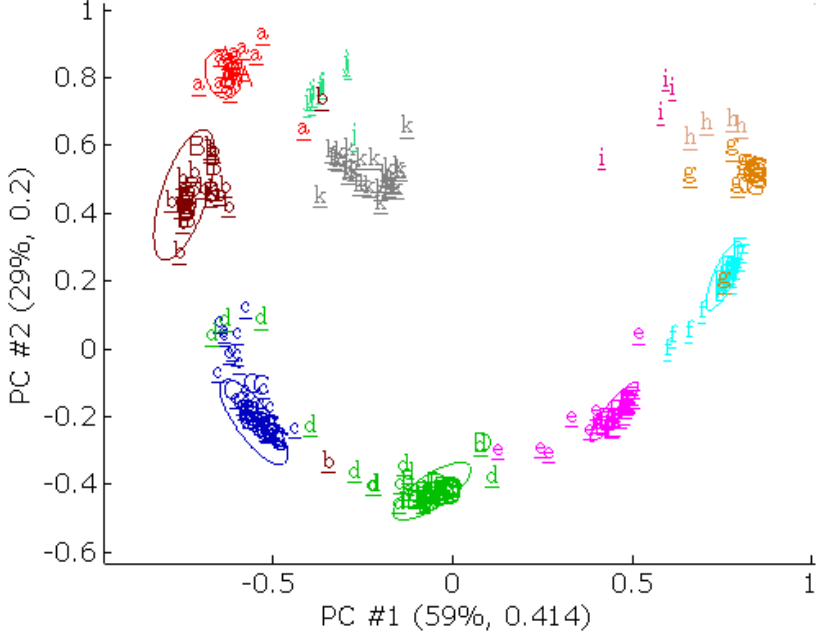
Table 8. The average prediction accuracies of the SVM, RF, RBFCCN, and BNN models were